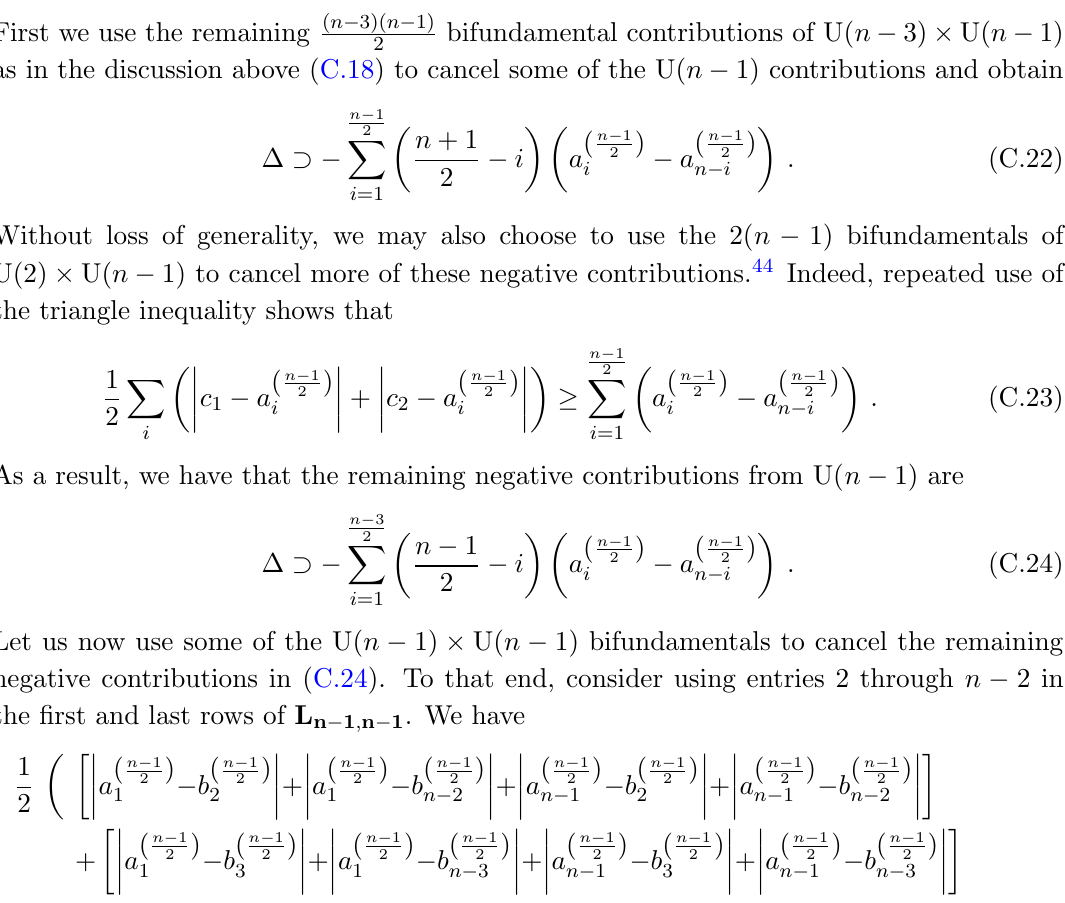
Figure 21 . After cancelling the negative contributions from the left and right quiver tails, we put a \+" in each corresponding node. We are left over with ( n (cid:0) 3)( n (cid:0) 1) from bifundamentals of U( n (cid:0) 3) (cid:2) U( n (cid:0) 1) in each quiver tail, and this has been encoded in the corresponding numbers on the tail links emanating from the U( n (cid:0) 1) nodes. The remaining numbers associated with the core links indicate the total number of unused (bi)fundamental contributions to